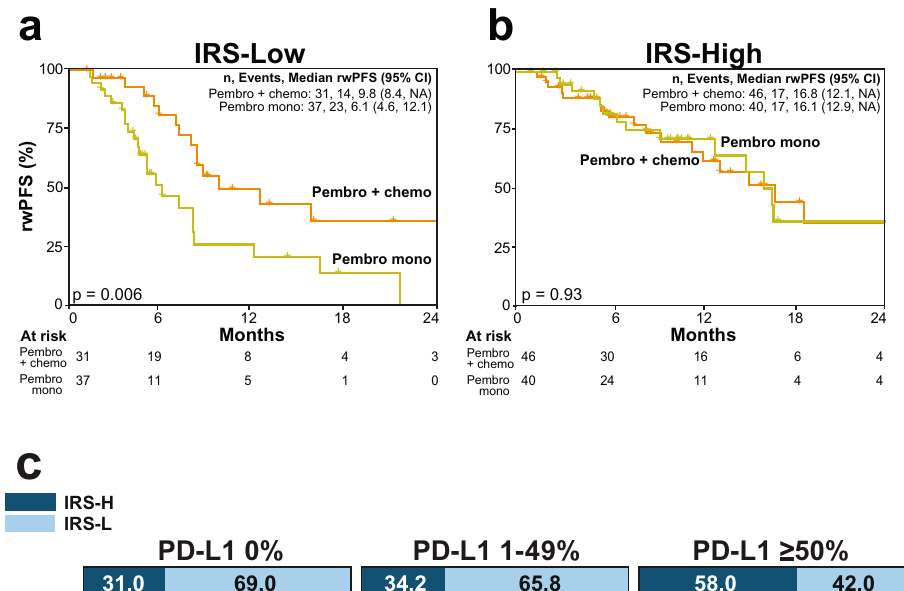
Fig. 4 Immunotherapy response score (IRS) for predicting pembrolizumab monotherapy vs. combination chemotherapy bene fi t in fi rst line non-small cell lung carcinoma (NSCLC). Propensity score matching (see Methods) was used to identify matched cohorts of patients with NSCLC treated with fi